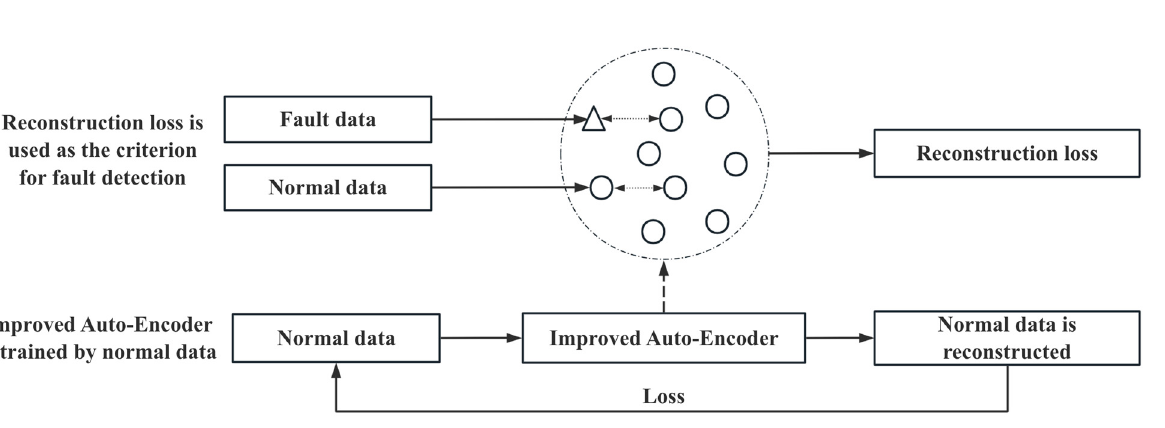
Figure 7. The flow chart of the proposed improved Auto-Encoder.